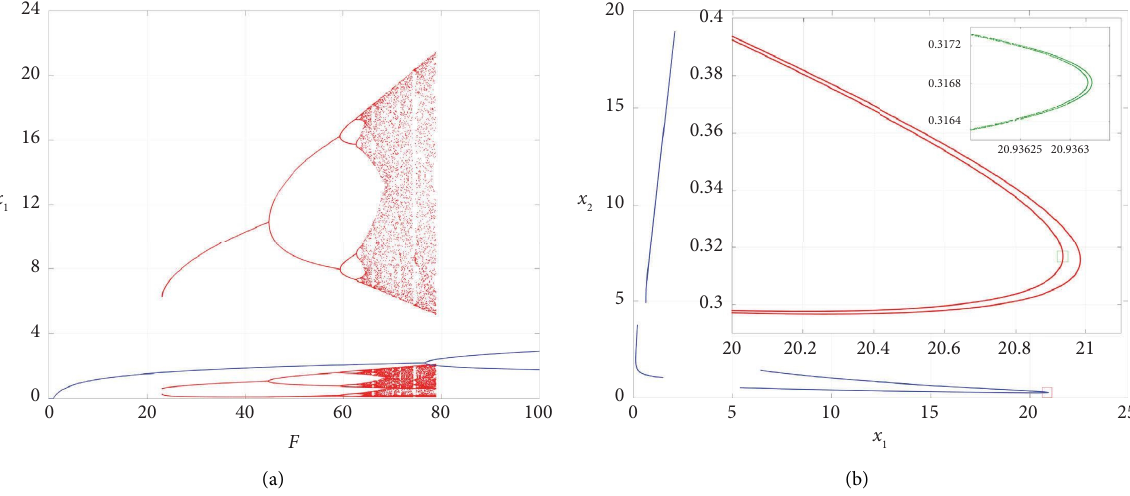
Figure 3: (a) Bifurcation diagram generated by map (1): parameter values ( μ Figure 2(a) and (b) chaotic dynamics generated by map (1), with zooms showing fractal structure. Parameter values ( μ , μ , p,F ) � ( 1 , 0 . 1 , 0 . 9 , 77 ) . 1 2